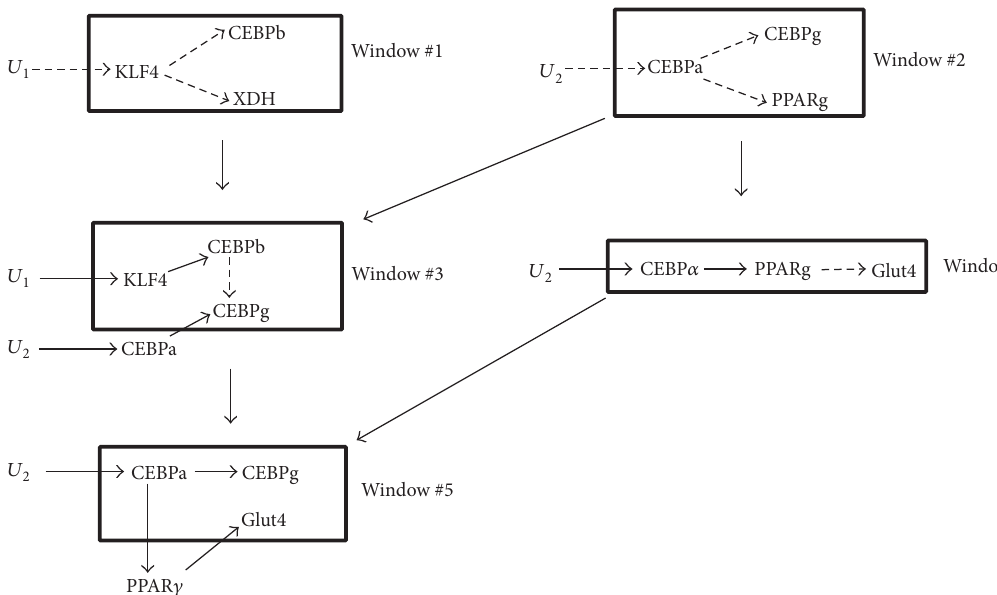
Figure 6: Windows of 7-gene adipogenesis network. All windows covering the 7-gene network are shown. Newly inferred gene interactions inside the window are indicated by broken arrows while interactions inferred from a previous window are indicated by solid arrows. Window #5 did not have any broken arrows connecting genes because no new gene relationships were inferred; the null hypothesis was the optimal regulatory relationship connecting genes. Furthermore, windows contributing gene relationships to other windows are shown by solid arrows between windows.